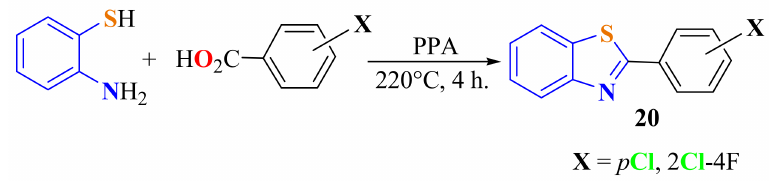
Scheme 10. Condensation reaction to give 2-halophenylbenzothiazoles. Serdons et al. reported the condensation of ATP with p -nitrobenzoic acid in the presence of PPA at 150 ◦ C for 1 h to give 2-( p -nitrophenyl)BT 21 in a 35% yield as the starting material for the synthesis of F-labeled 2-( p -fluorophenyl)BT 22 (Scheme 11). The compounds were evaluated as amyloid imaging agents in Alzheimer’s disease [78].